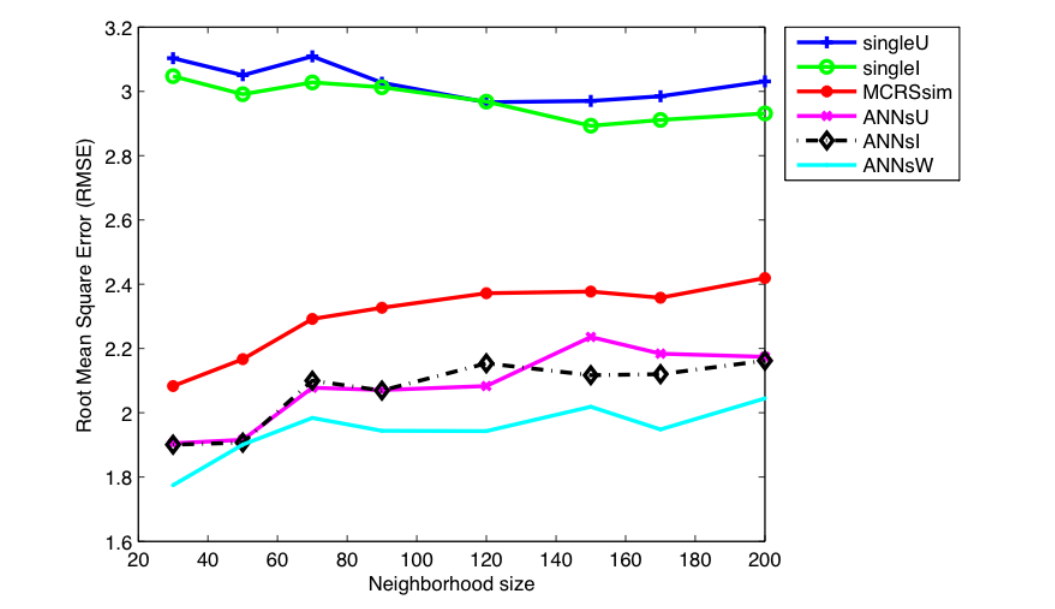
Figure 4. Curves of root mean square error (RMSE) against the neighborhood size.